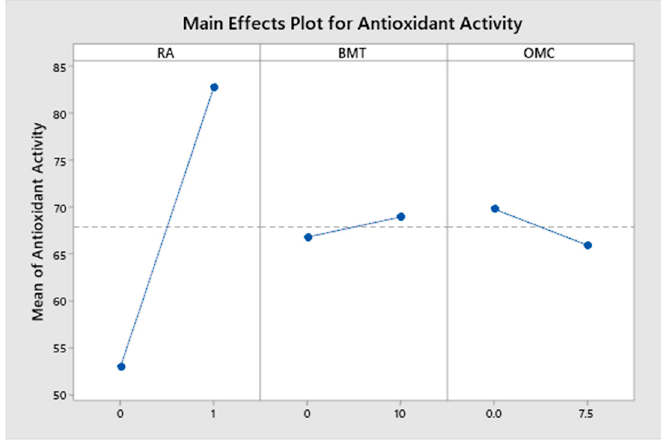
Figure 2. Graph of main effects for the antioxidant activity of the formulations.